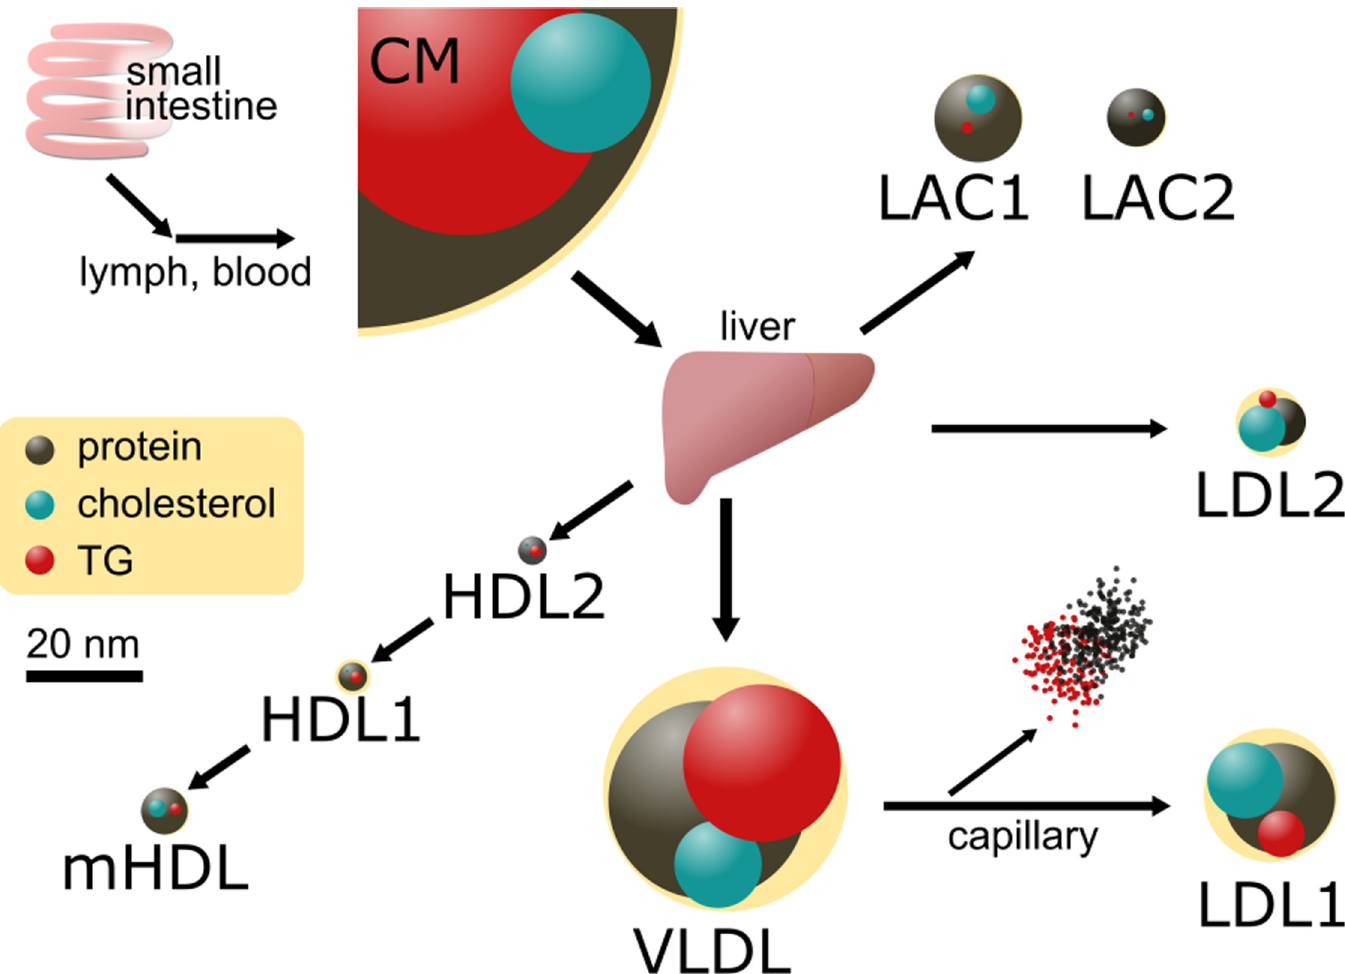
Fig 8. Alternative schematic flowchart of lipoprotein metabolism in rat. Relative amounts of cholesterol, TG, and proteins are indicated as spheres on a pale-yellow background that indicates the size of the lipoprotein.